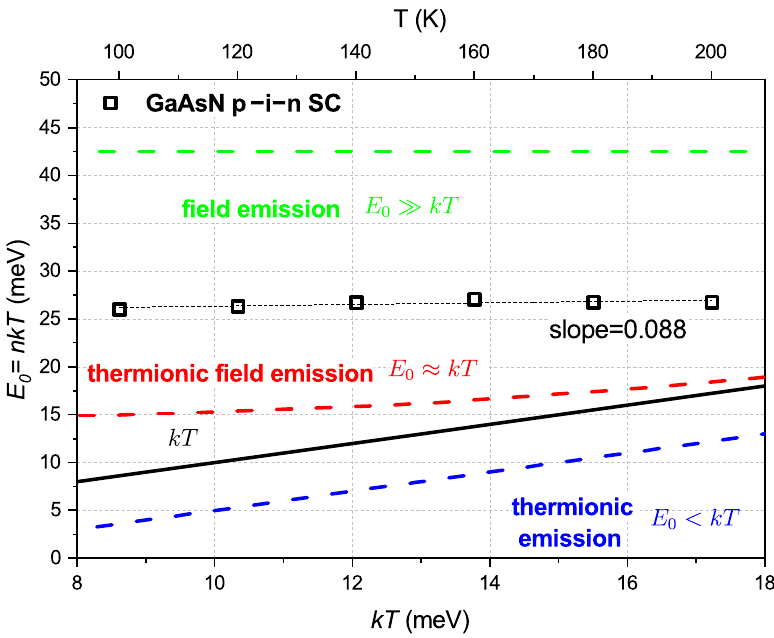
Figure 9. Relation between nkT and kT showing basic variation of tunneling mechanism dominant in the LT